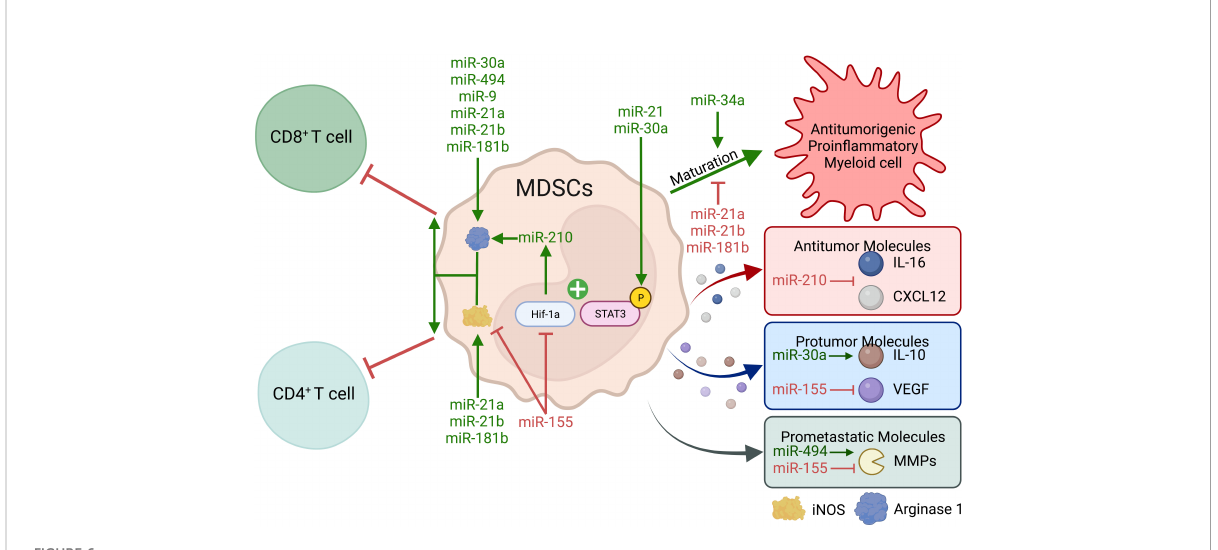
FIGURE 6 Myeloid-derived suppressor cell miRNAs alter the immune-suppressive capacity of MDSCs. MDSCs have many mechanisms to inhibit anti-tumor T-cell responses and promote tumor progression. Most MDSC miRNAs promote Arginase and iNOS-mediated CD4+ and CD8+ T-cell suppression. Conversely, several miRNAs promote the maturation of MDSCs into proin fl ammatory myeloid cells with anti-tumor and M1 macrophage functions. miR-155 can inhibit MDSC suppressive function, tumor vascularization, and metastatic potential; although its role in MDSC function is